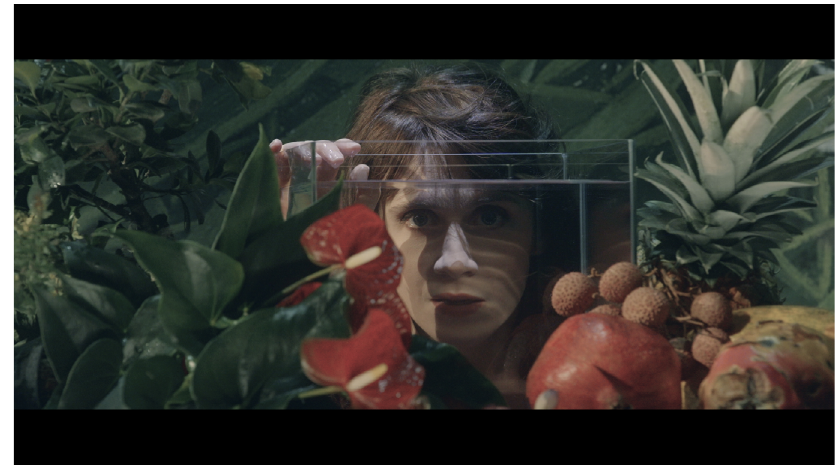
Fig. 4 – Marc-Antoine Charpentier, Actéon , directed by Benjamin Lazar, still photo. © Camera Lucida